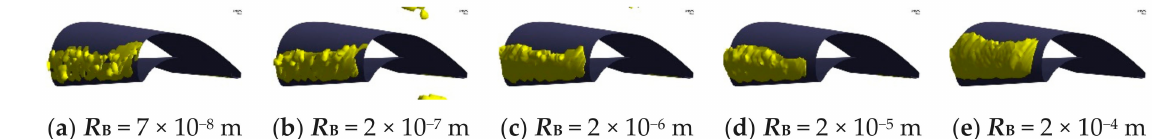
Figure 29. The 10% vapor volume fraction distribution in stator domain at stall under various mean